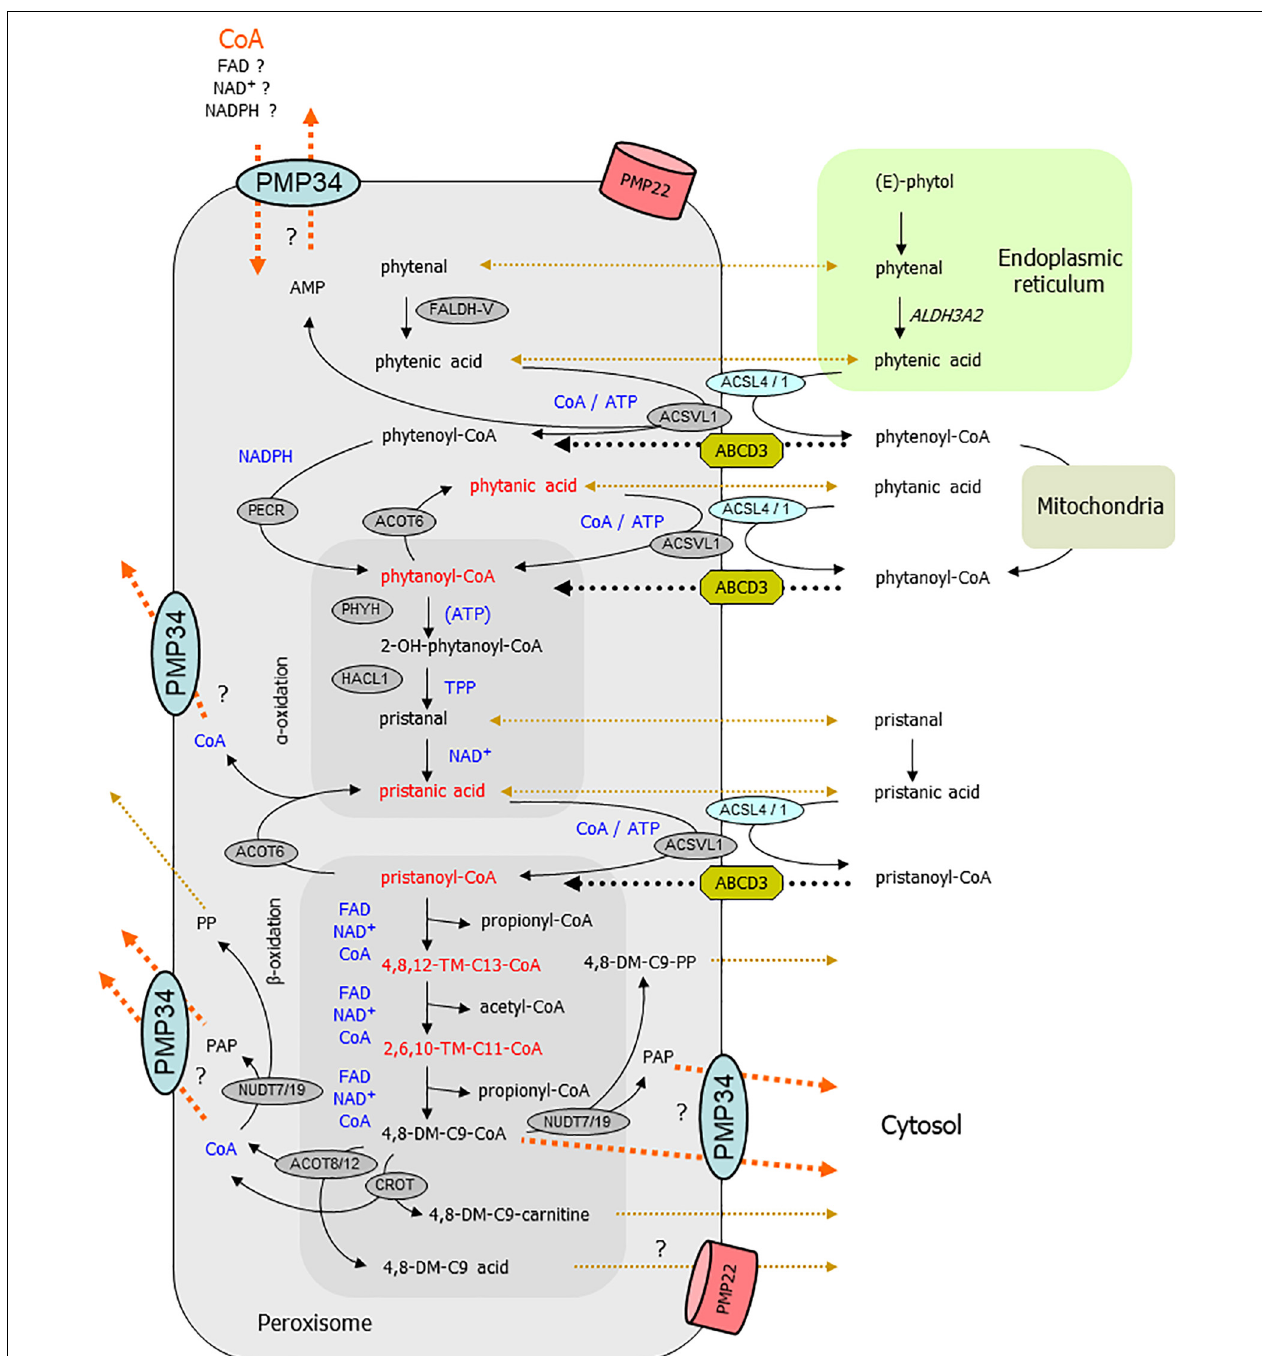
FIGURE 10 | Link between PMP34 and peroxisomal phytol degradation. Schematically shown are the different steps involved in phytol breakdown and their (presumed) subcellular sites. Cofactors involved in intraperoxisomal reactions are highlighted in blue; enzymatic steps are drawn with solid black arrows; transport processes are shown with dotted lines, black for known or accepted ones, ochre-brown for non-characterized or putative ones, orange for (hypothesized) PMP34 related ones. The areas depicting reactions related to α - and β -oxidation are tinted darker. Compounds (or their hydrolysis product) depicted in red accumulate in phytol treated PMP34 knockout mice. Likely, different phytol derivatives can enter peroxisomes (phytol, 2-phytenal, 2-phytenic acid, phytanic acid, 2-phytenoyl-CoA, phytanoyl-CoA, phytanic acid), the CoA-esters presumably via ABCD3, but whether or not hydrolysis occurs during this transport is not specified. Activation of phytanic acid by ACSVL1 requires intraperoxisomal ATP/CoA (and export of generated AMP, perhaps via PMP34), but phytanic acid could also be activated at the cytosolic side of the peroxisomal membrane by ACSL4/1. In the α -oxidation process, ATP stimulates PHYH but is not required for its activity. Before pristanic acid, produced by α -oxidation, can enter the β -oxidation spiral, it needs to be activated to its CoA-ester, a CoA/ATP-dependent step which could be carried out in the